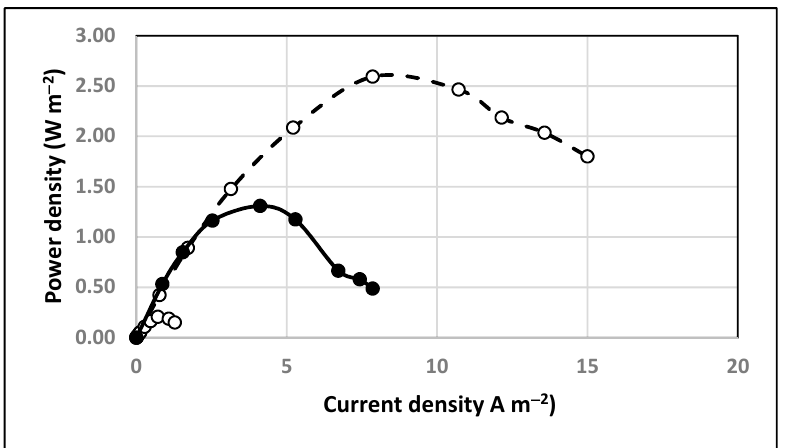
Figure 3. Generated cell voltages at different sulfide concentrations. Single fuel cell. Batch process. Direct aeration. Solid line (o)—70 mg dm − 3 ; dashed line (o)—240 mg dm − 3 ; solid line ( • )—670 mg dm − 3 .